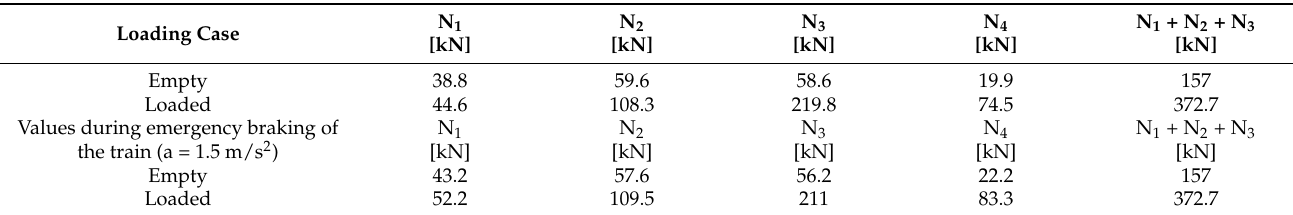
Table 1. Normal forces between the road vehicle and the railway wagon platform for the static loading case and during emergency braking.